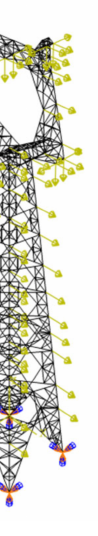
Figure 4. Load application on transmission tower.